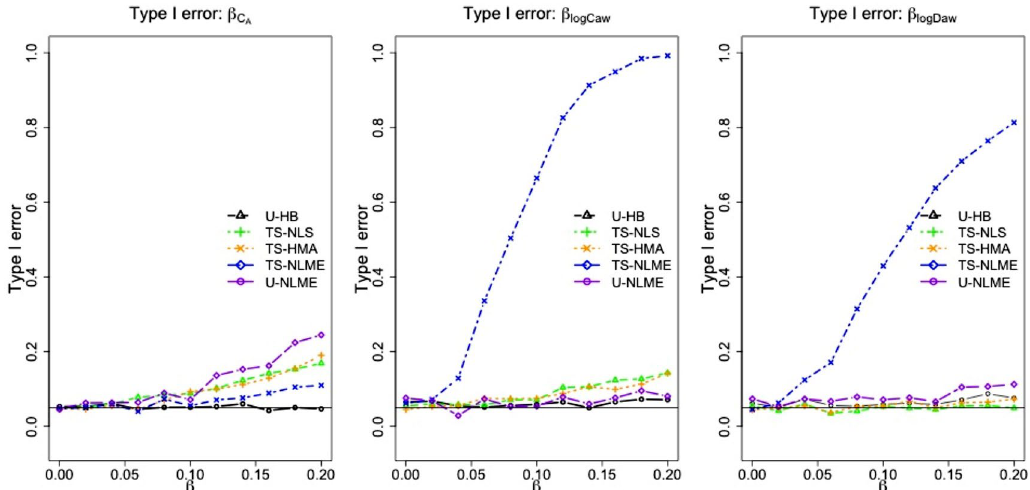
Figure 3. Type I error* of the selected estimation methods from the simulation study.* With the type I error calculated for β C using Scenario 5 with β C A = 0 ; and for β logD β logC using Scenario 7 with β C aw aw